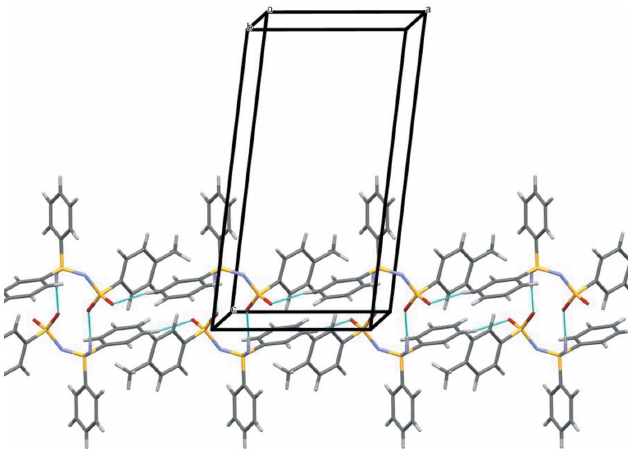
Figure 3 A partial packing diagram of the title compound, showing the tape along the a- axis direction formed via N—H (cid:4)(cid:4)(cid:4) O and C—H (cid:4)(cid:4)(cid:4) O hydrogen bonds (blue dashed lines).